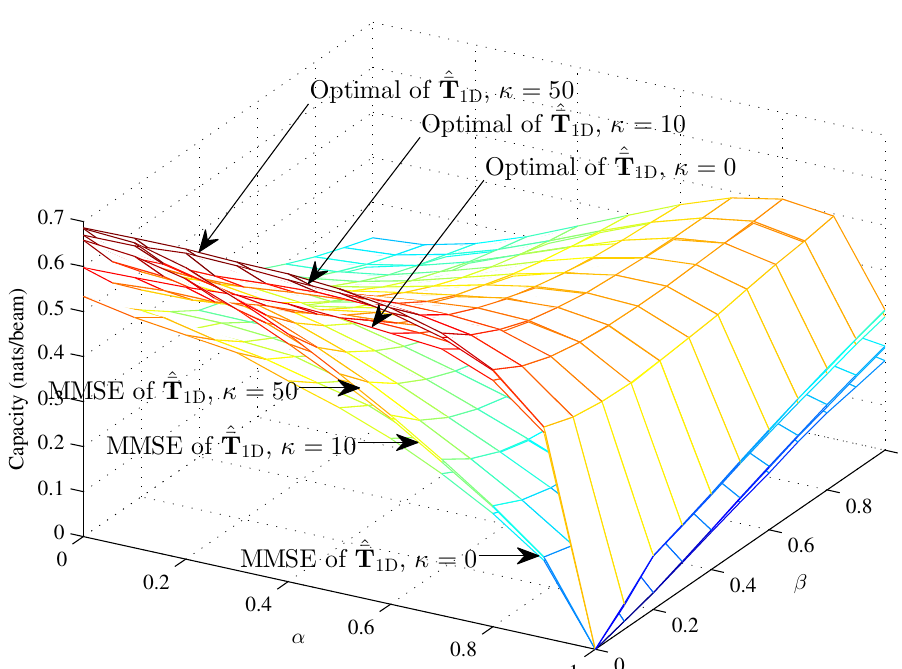
Figure 8. The optimal capacity and MMSE capacity of the modified hybrid 1D beams with γ = 1 and N = 100 ( κ = 0, κ = 10 and κ = 50) versus α and β .